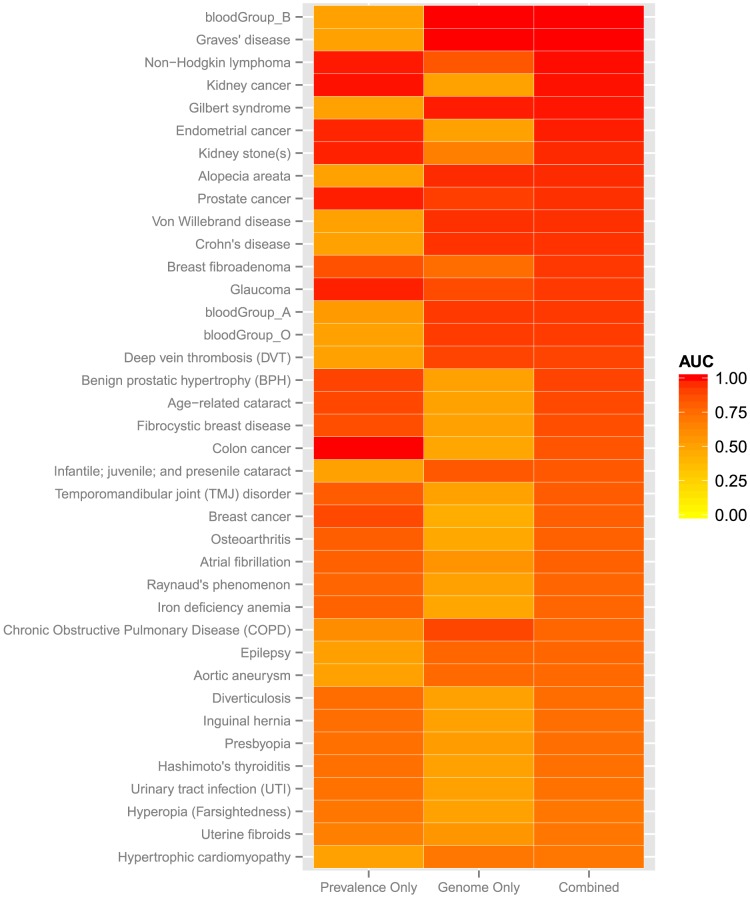
Contribution of population prevalence and genome sequence to prediction results in Fig. 1.Each row represents a phenotype and consists of three cells, representing (a) model predictions based only on phenotype-specific population prevalence (Prevalence Only), (b) model predictions based on genome sequence (with assumption that every phenotype and every individual has the same prevalence), and (c) model predictions that combine genome sequence and phenotype-specific population prevalence. Cells are colored by the area under the ROC curve (AUC) yielded by each model. Contributions vary among phenotypes due to differences in quality of available information with respect to prevalence and database annotations of variant genotypes.